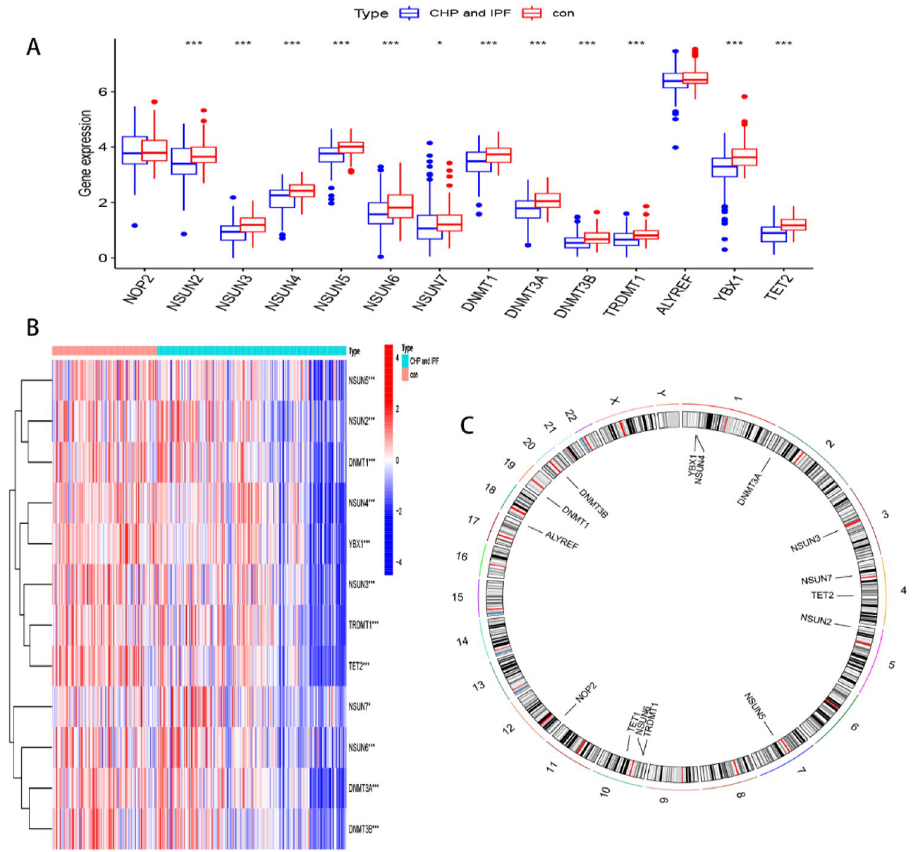
Figure 2. Landscape of the m5C regulators in CHP and IPF. ( A ) The boxplot of 14 m5C regulators expression in tests (CHP and IPF) and controls. ( B ) Expression of 12 significantly differentially expressed m5C regulators in tests and controls. * p < 0.05, ** p < 0.01, and *** p < 0.001. ( C ) Chromosomal positions of those m5C